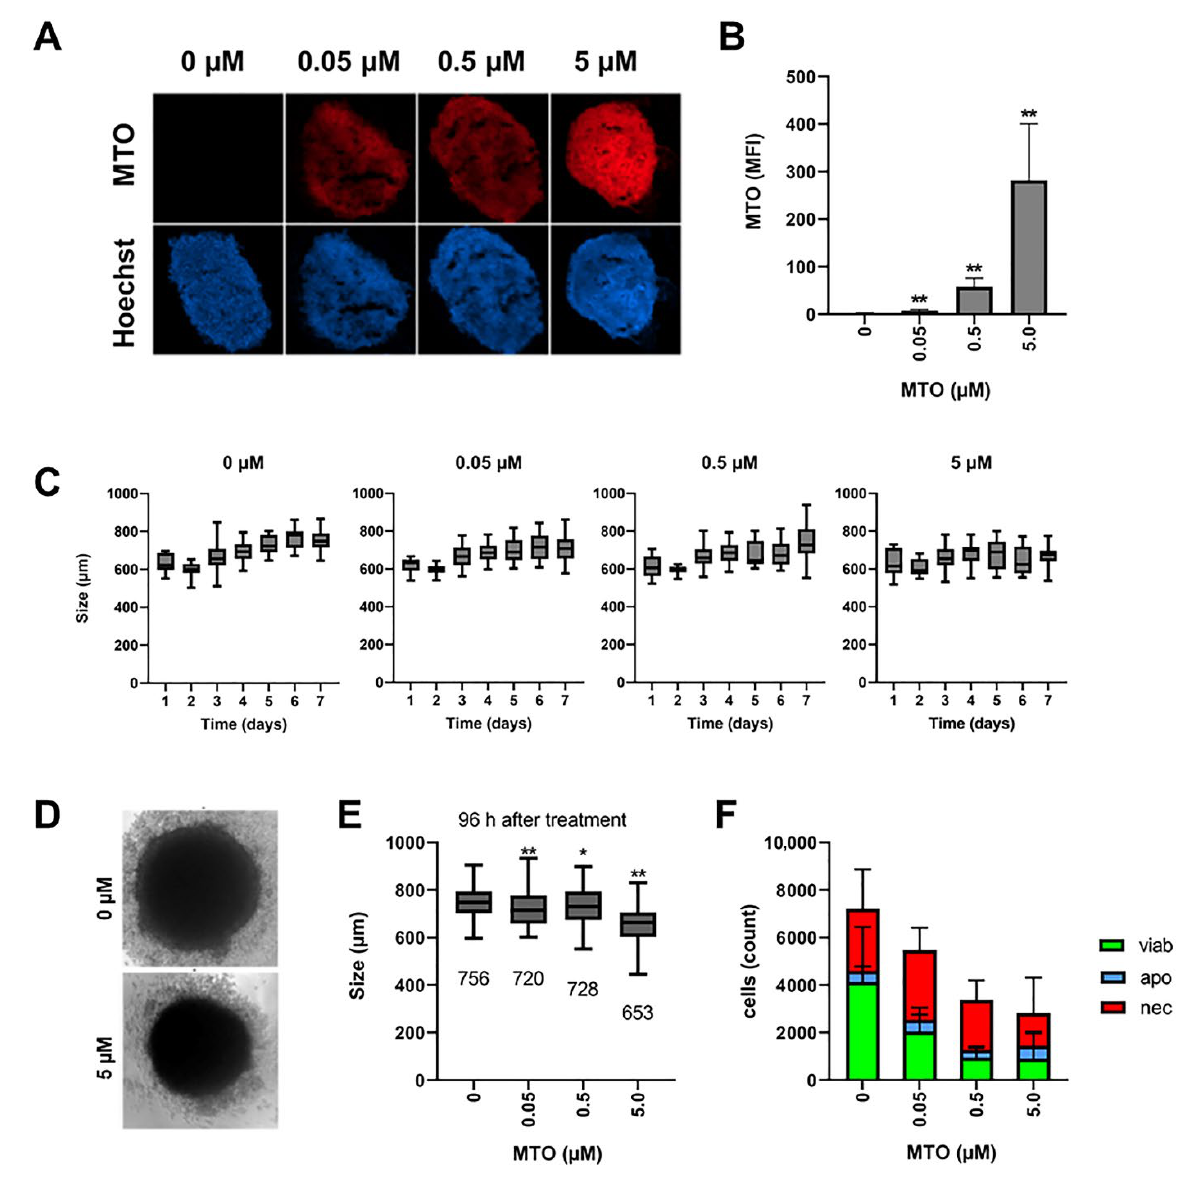
Figure 1. Accumulation of MTO and induction of cell death in spheroids. Spheroids were cultured from A375M cells and fibroblasts in agarose-coated wells for 72 h, then mitoxantrone was added. ( A ) Fluorescence microscopy of cryosections of the spheroids on day 7. ( B ) Single-cell suspensions of the spheroids were analyzed in flow cytometry for intracellular MTO fluorescence on day 7. ( C ) Transmission microscopy and determination of spheroid size by Image J software. ( D ) Transmission microscopy after 96 h of incubation with MTO and ( E ) size determination. ( F ) AxA5-PI staining of single cell-suspensions on day 7. The experiment was performed four times with n > 18 ( C – E ), or three times in triplicates ( B , F ). The mean values with standard deviations are shown. Significances (treatment versus control) were calculated using one-way ANOVA with * p ≤ 0.01 and ** p ≤ 0.05.